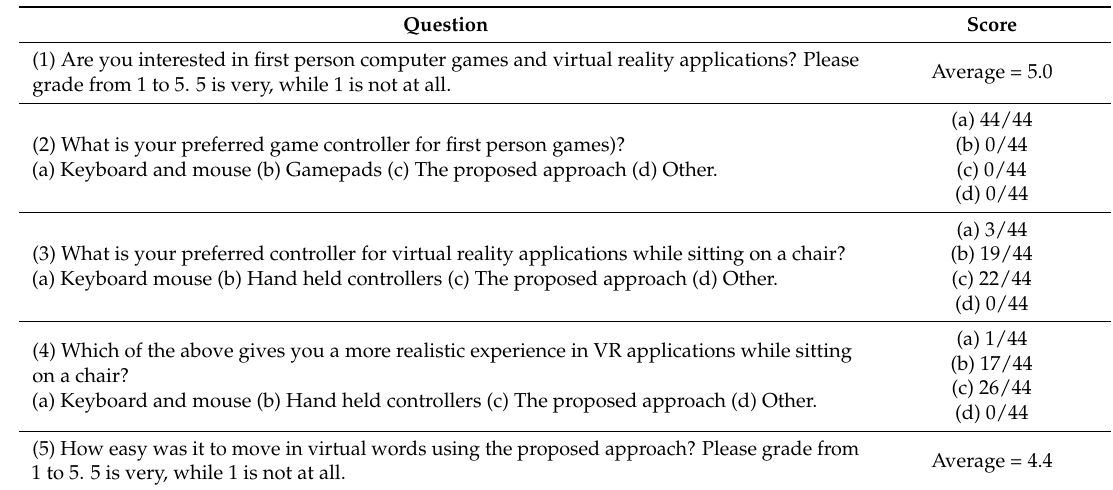
Table 1. Evaluation of User Satisfaction.